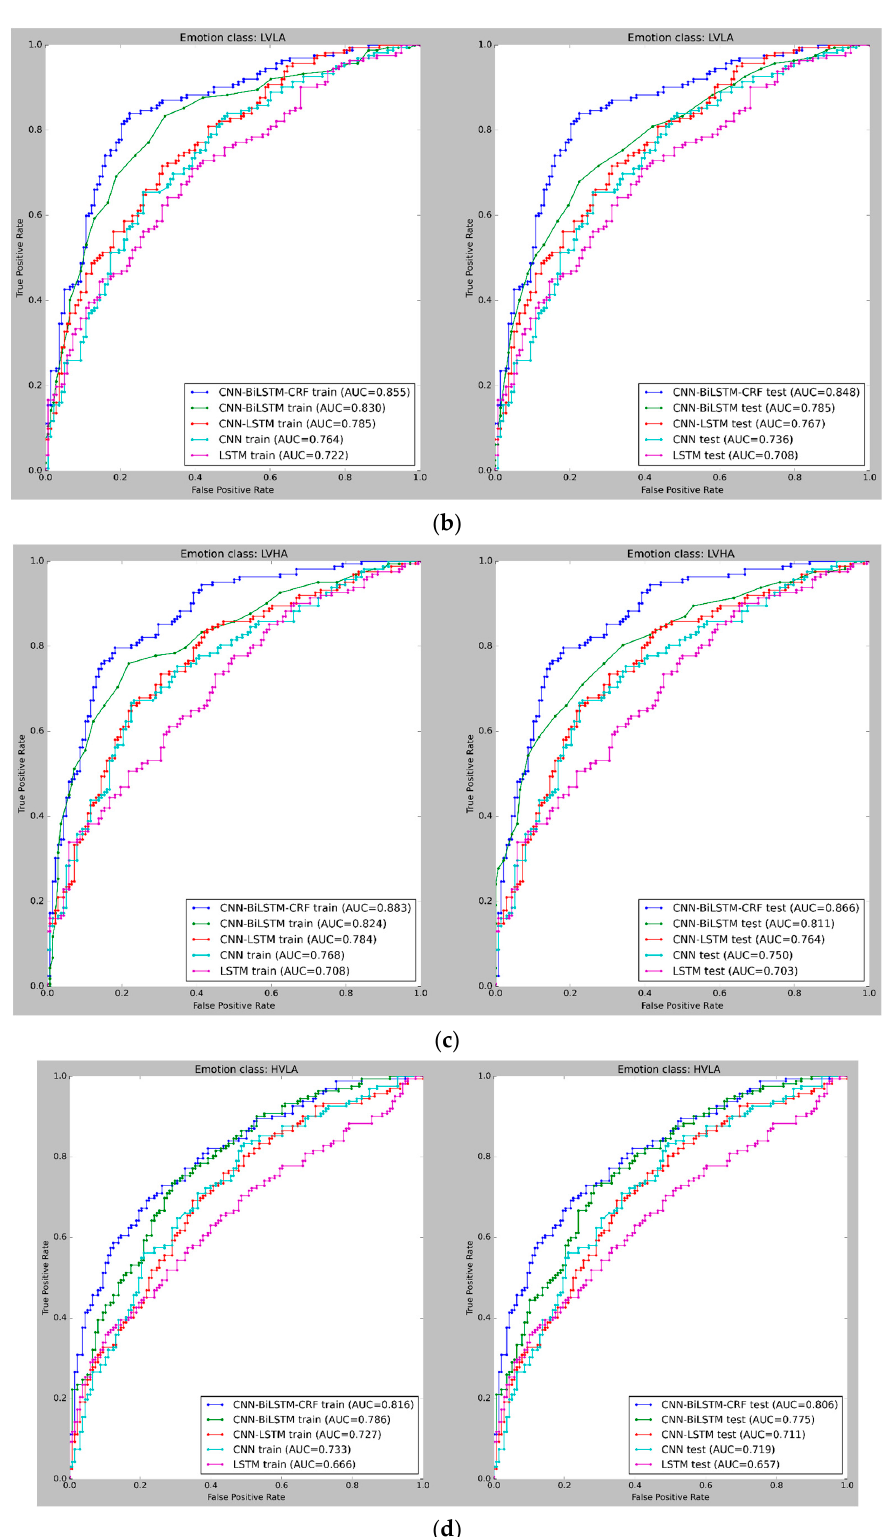
Figure 10. ( a – c ) ROC curves for emotion classification in Experiment 2, using cross-validated training and test datasets for all four emotion classes: High Valence High Arousal (HVHA), Low Valence Low Arousal (LVLA), and Low Valence High Arousal (LVHA). ( d ) ROC curves for emotion classification in Experiment 2, using cross-validated training and test datasets for all four emotion classes: High Valence Low Arousal